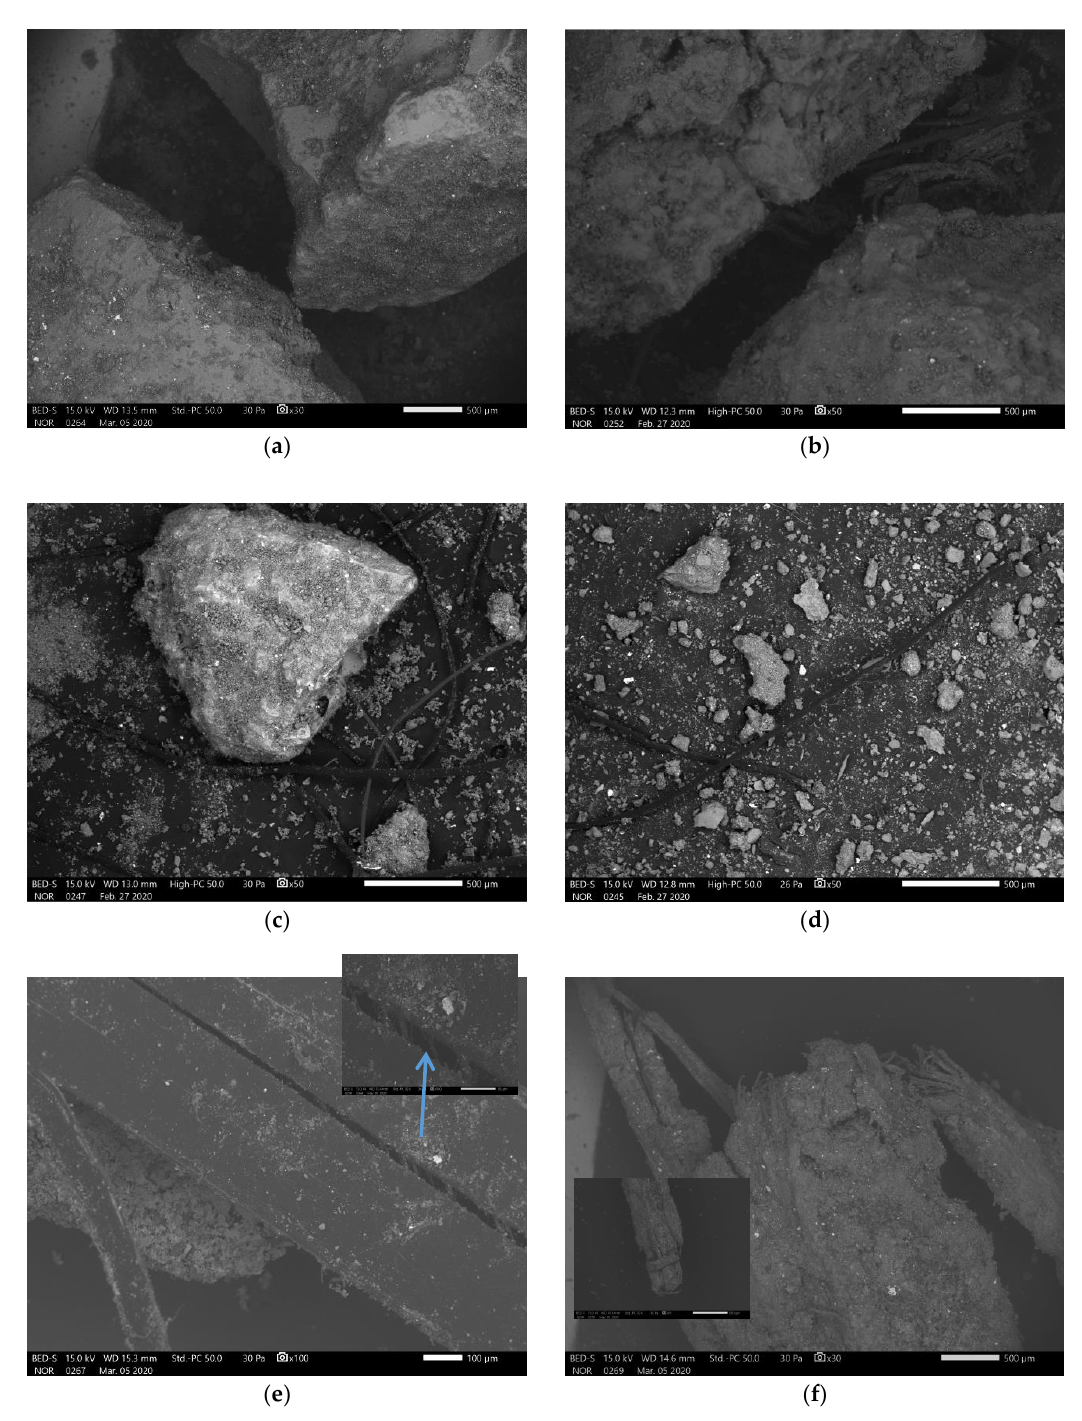
Figure 2. SEM micrographs of RM sieved ( a , e , f ) above 4 mm, ( b ) between 2 mm and 4 mm, ( c ) between 1 mm and 2 mm and ( d ) below 1 mm.